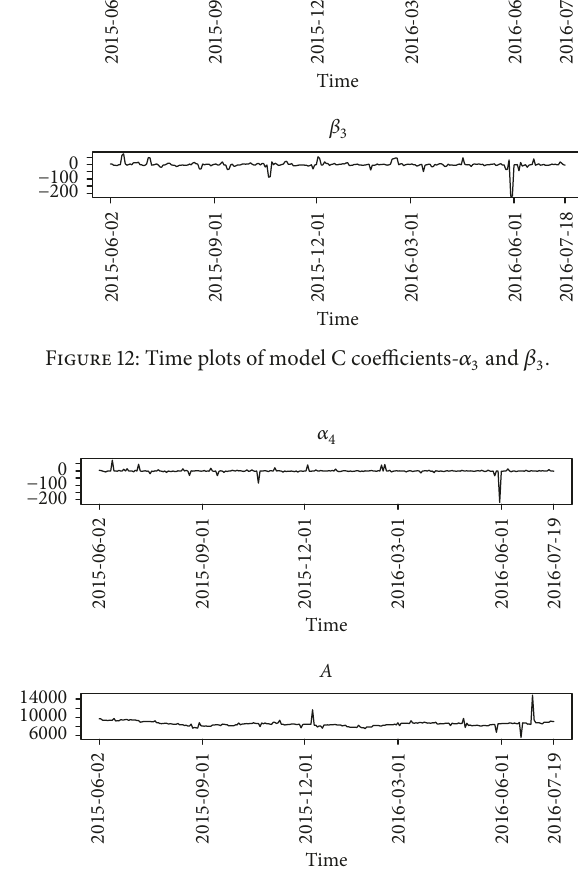
Figure 11: Time plots of model B coefficients- 𝛼 2 and 𝛽 2 .